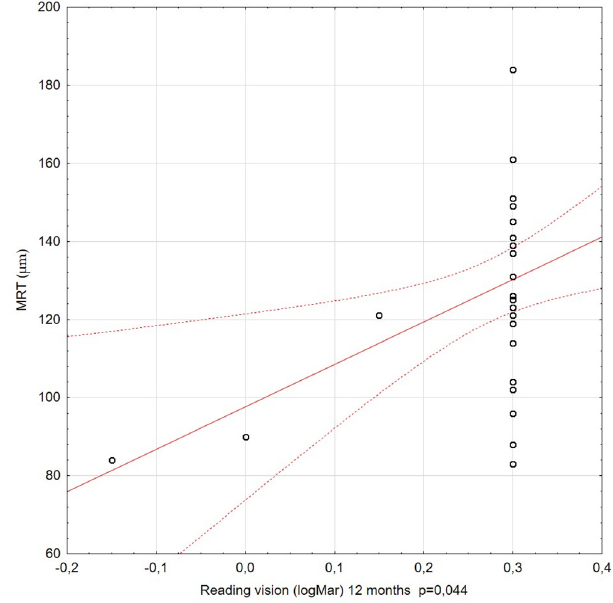
Figure 10. Correlation between reading vision (RV) (at 12 months) and minimal retinal thickness (MRT). A statistically significant correlation was observed: better RV correlated with higher MRT values.